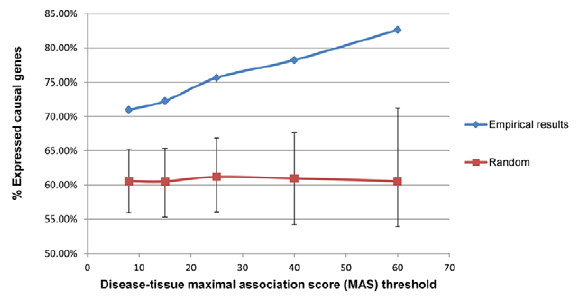
Figure 1. The fraction of disease genes expressed in the disease’s assigned tissue correlates with MAS Threshold. The fraction of disease-causing genes expressed in the tissue of their pertaining disease, compared to the random expectation (obtained through a permutation test; Methods), for different MAS thresholds. The error bars represent the minimal and maximal fraction of expressed genes observed at random (over 10,000 permutations) for each MAS threshold. Total number of associations is (from lower to higher MAS): 920, 812, 583, 349 and 167.